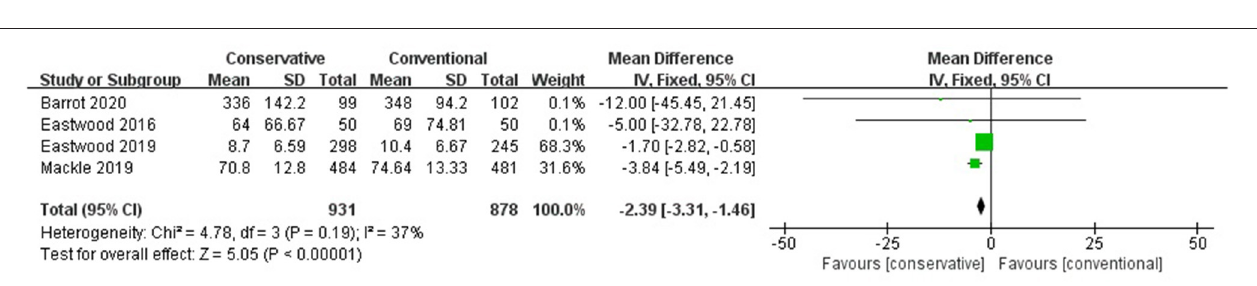
FIGURE 5 | MV hours. CI, confidence interval; MD, mean difference; MV, mechanical ventilation; SD, standard